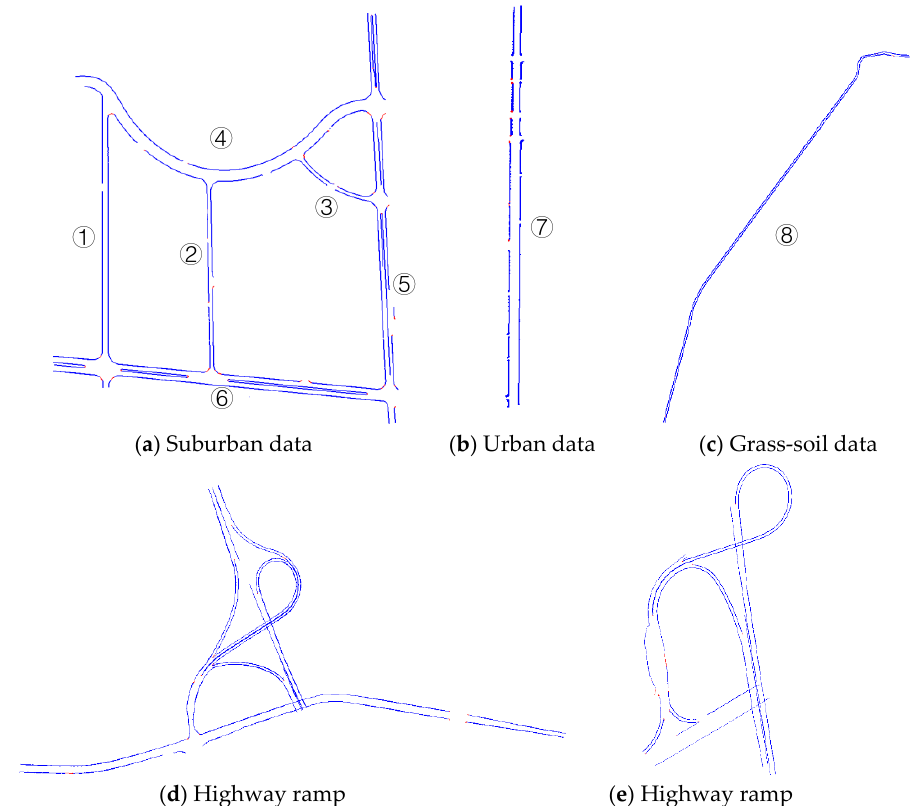
Figure 12. Extraction results for road edges; non-extracted road edges are indicated in red, and extracted road edges are indicated in blue.